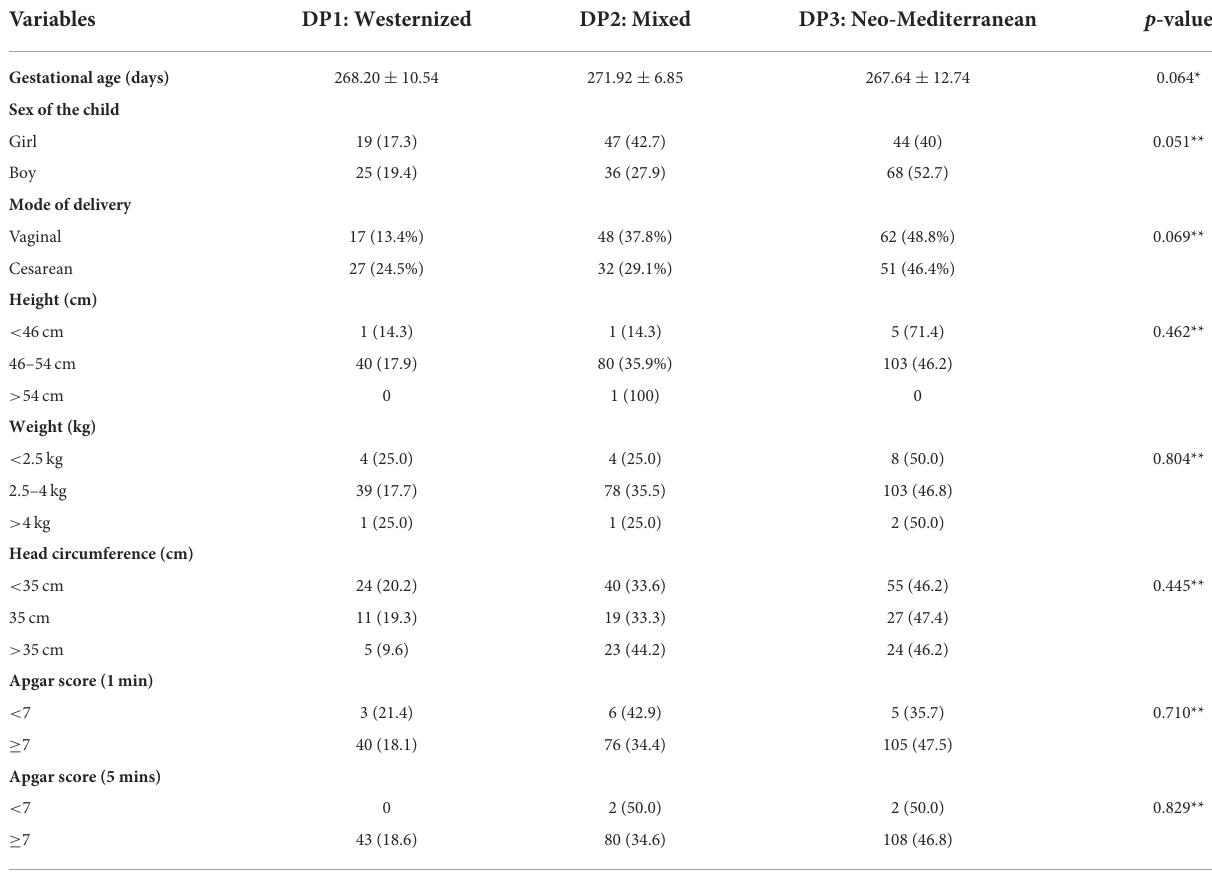
TABLE 6 Pregnancy related factors and dietary patterns during pregnancy (N = 358 † ). Variables DP1: Westernized DP2: Mixed DP3: Neo-Mediterranean p